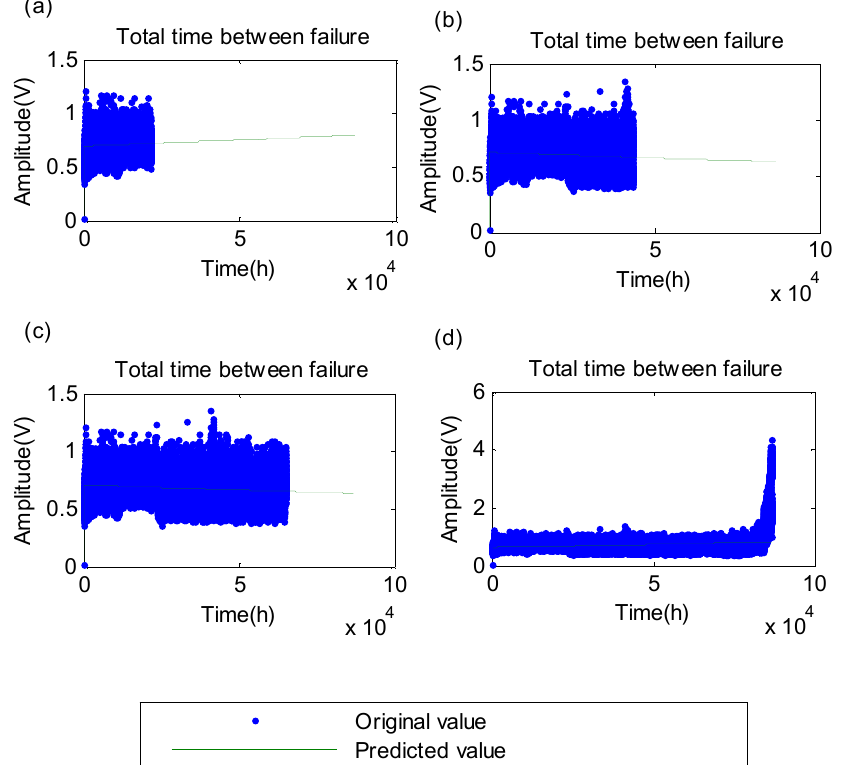
Figure 6. The RUL prognostics results with the energy of the original signal utilizing grey theory: ( a ) prognostics result based on 25% of the original data; ( b ) prognostics result based on 50% of the original data; ( c ) prognostics result based on 75% of the original data; ( d ) prognostics result based on 100% of the original data.